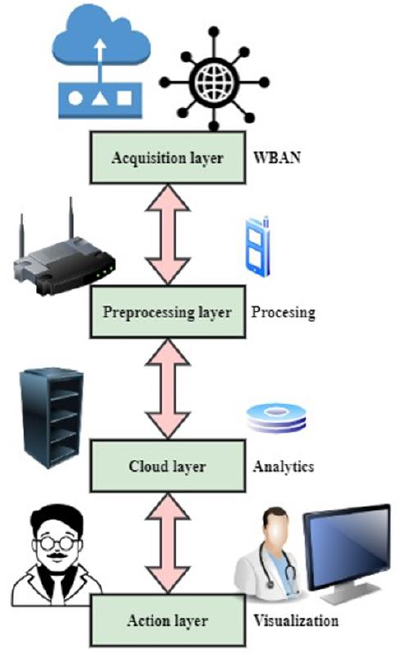
Figure 1. The proposed IWMCPS model architecture.